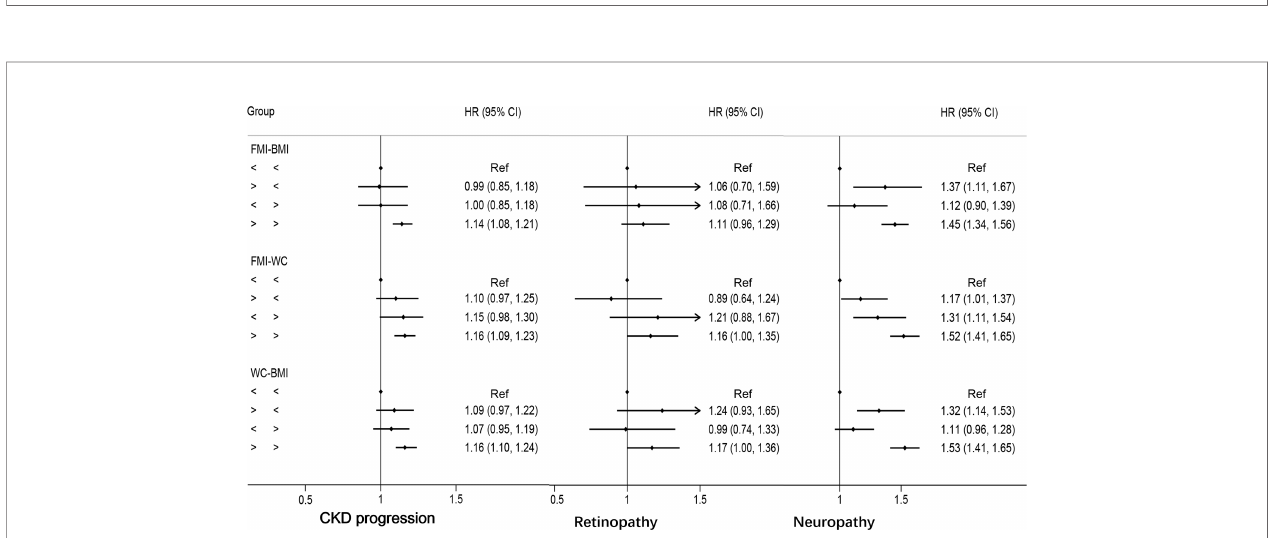
FIGURE 4 | Multivariable-adjusted hazard ratios of primary endpoints by discordant versus concordant categories of fat mass index, body mass index, and waist circumference in type 2 diabetes mellitus patients. Adjusted for model 3: age, race, sex, glucose control, diabetes duration, proteinuria, current smoking, weekly alcohol consumption, height, glomerular fi ltration rate, total cholesterol, low density lipoprotein cholesterol, high density lipoprotein cholesterol, systolic blood pressure, and hemoglobin A1C. HR, hazard ratios; CI, con fi dence interval; CKD, chronic kidney